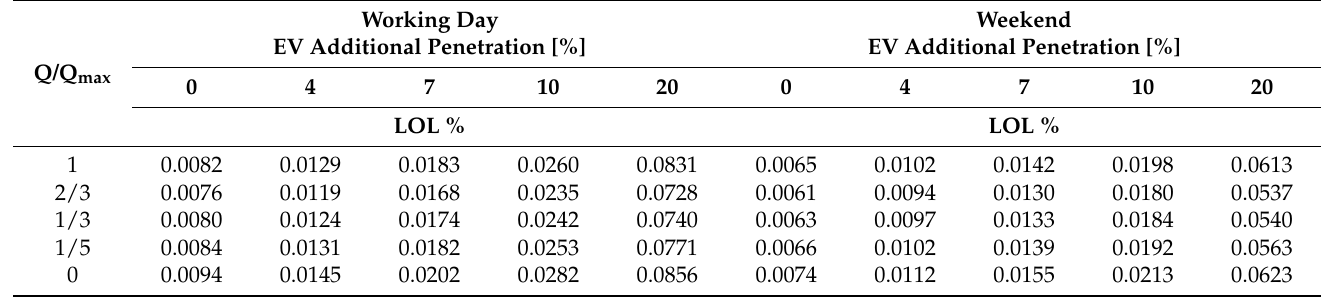
Table 6. LOL for different levels of reactive power for T 1 for different additional penetration